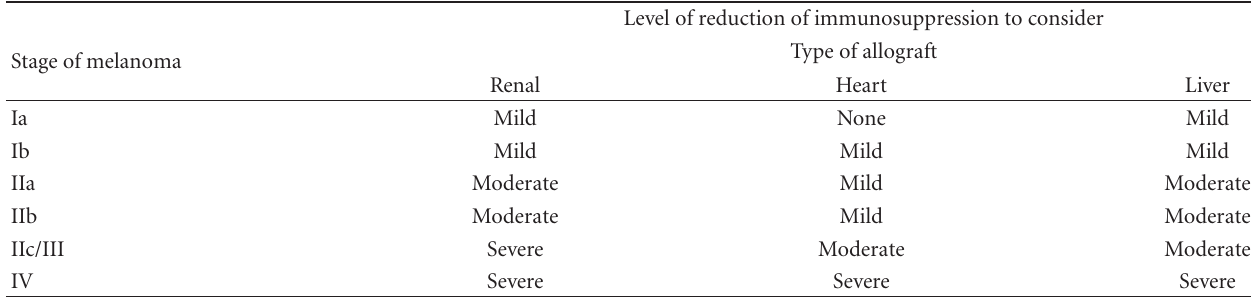
Table 1: Recommendation for level of reduction of immunosuppression to consider in varying stages of melanoma based on expert consensus (adapted from